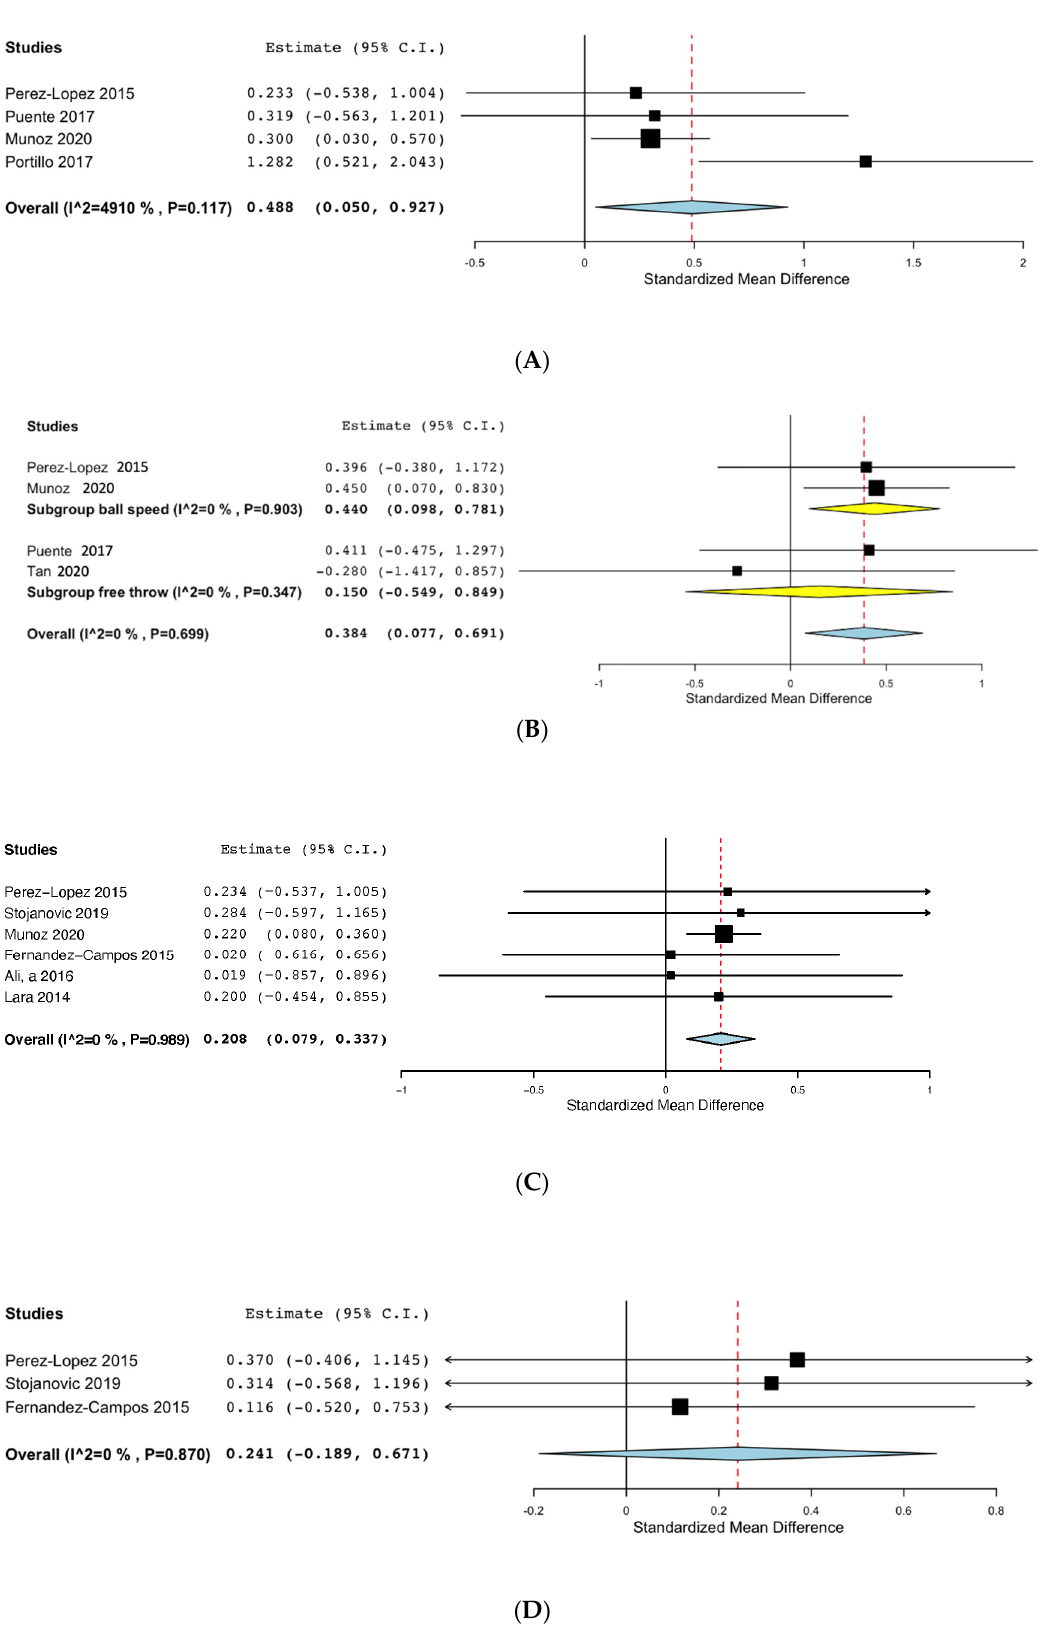
Figure 2. ( A ): Effects of caffeine on body impacts during a simulated match. ( B ): Effects of caffeine on specific skills. ( C ): Effects of caffeine on countermovement jump. ( D ): Effects of caffeine on squat